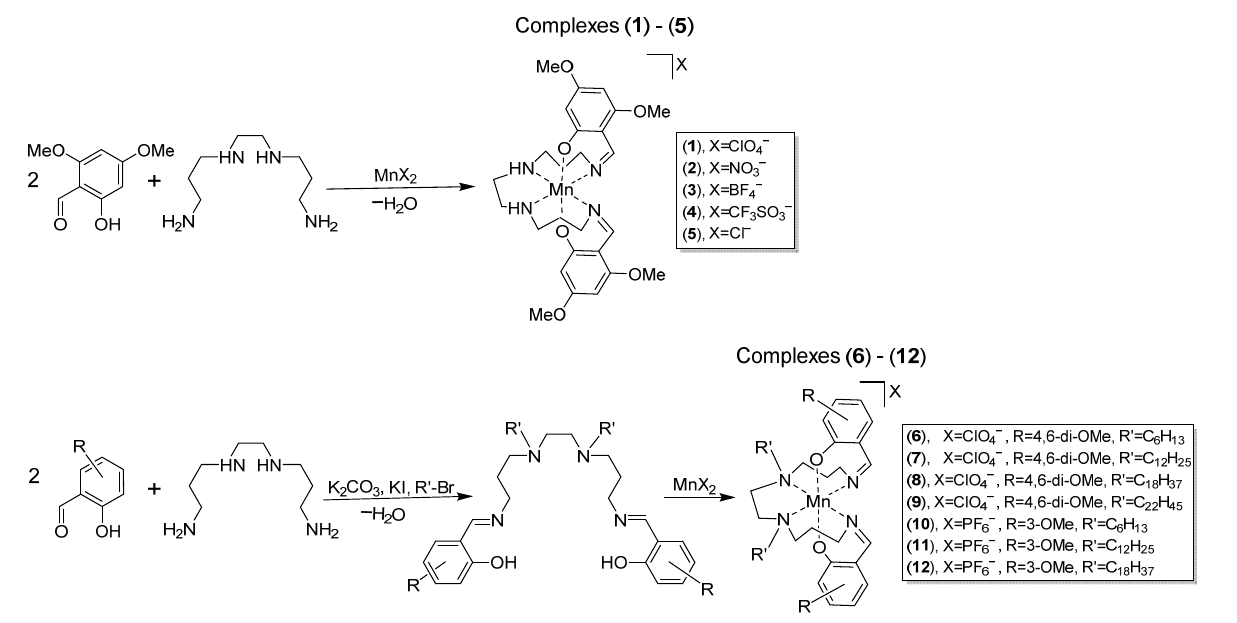
Figure 1. Synthetic route to complexes ( 1 )–( 12 ).